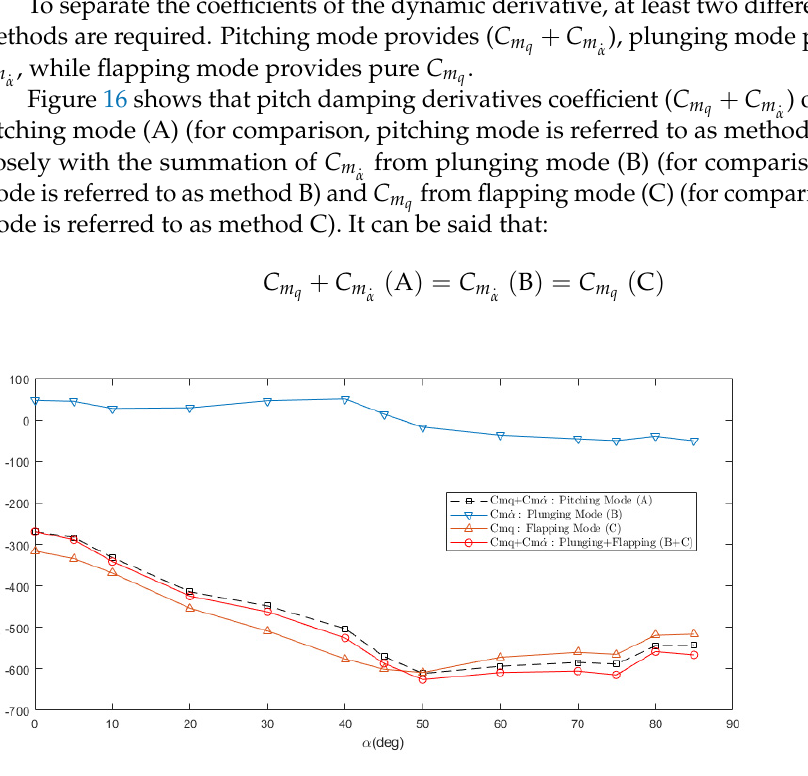
Table 3. Comparison of dynamic stability derivatives of forced pitching (A), forced plunging (B), and forced flapping (C).